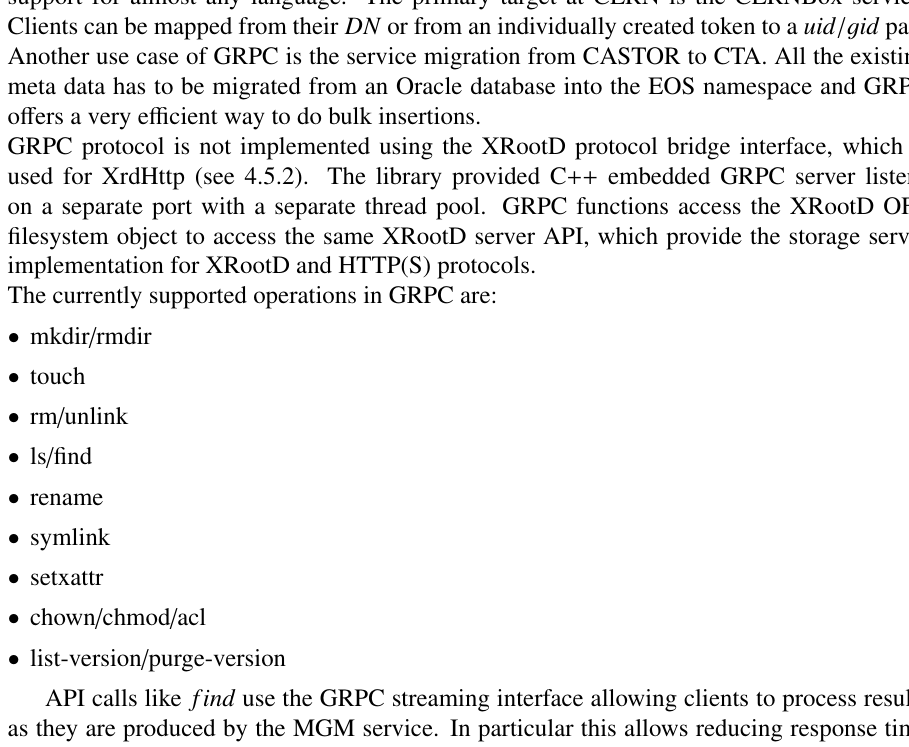
support for almost any language. The primary target at CERN is the CERNBox